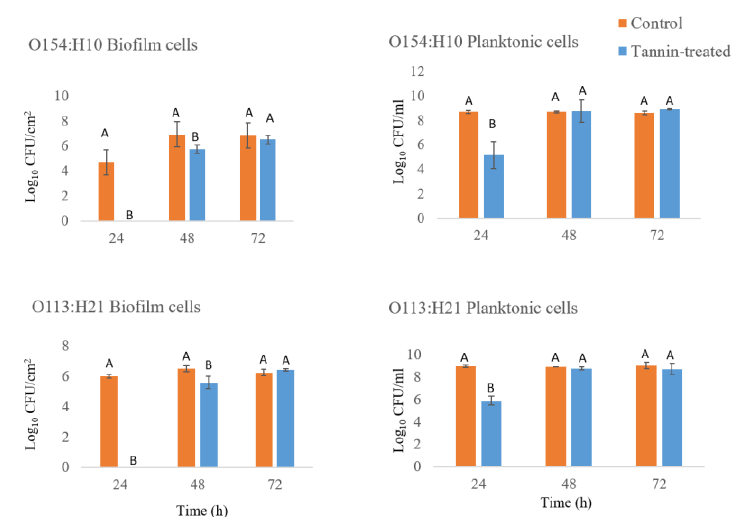
Figure 5. Effect of phlorotannins (50 µg/mL) on E. coli O154:H10 and E. coli O113:H21 biofilm formation and planktonic cell growth after 24, 48 and 72 h of exposure. Different uppercase letters denote differences at p < 0.05 among phlorotannin-exposed and controls. Bars = standard error ( n = 3).